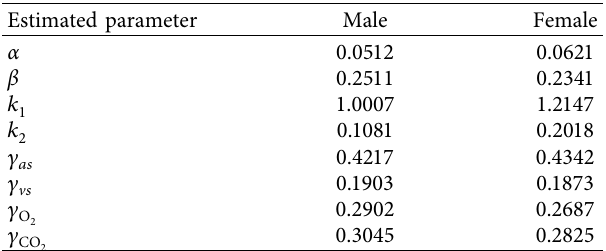
Table 3: Estimated model